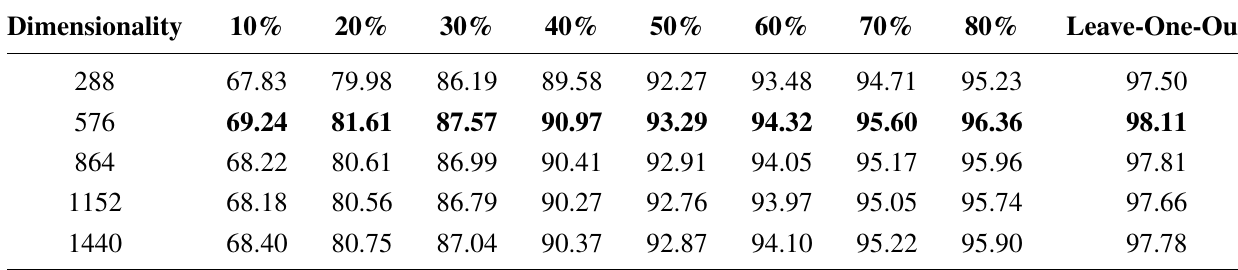
Table 8. Accuracy of infrared ATR (%) for sOC_RLTP by FSDE [47] under different training datasets.